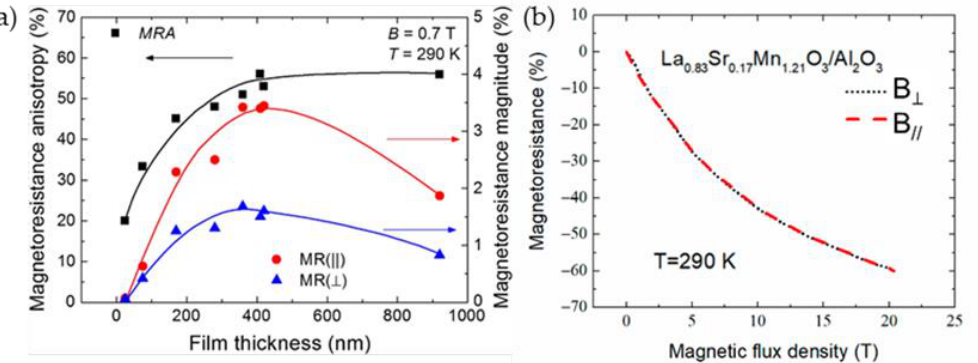
Figure 12. ( a ) The dependences magnetoresistance anisotropy MRA (left scale) and magnetoresistance MR in perpendicular ( ⊥ ) and parallel (||) to film plane field directions (right scale) on thickness of La 0.17 Sr 0.83 MnO 3 films grown on glass ceramics substrate. Reprinted with permission from [56]. Copyright 2018 Springer; and ( b ) magnetoresistance dependences on magnetic flux density for La 0.17 Sr 0.83 Mn 1.21 O 3 film grown on polycrystalline Al 2 O 3 , when the magnetic field was applied parallel and perpendicular to film plane. Reprinted from [68]. Copyright 2022 MDPI.